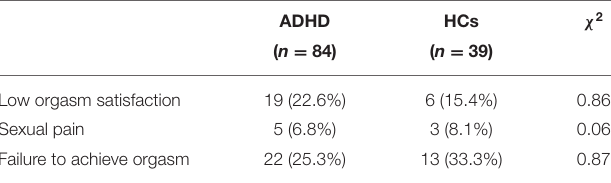
TABLE 8 | Frequency of sexual dysfunctions in women with ADHD compared to women without ADHD using the SBQ-G. ADHD